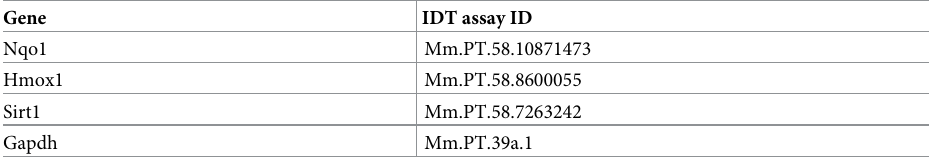
Table 1. Genes analyzed by quantitative